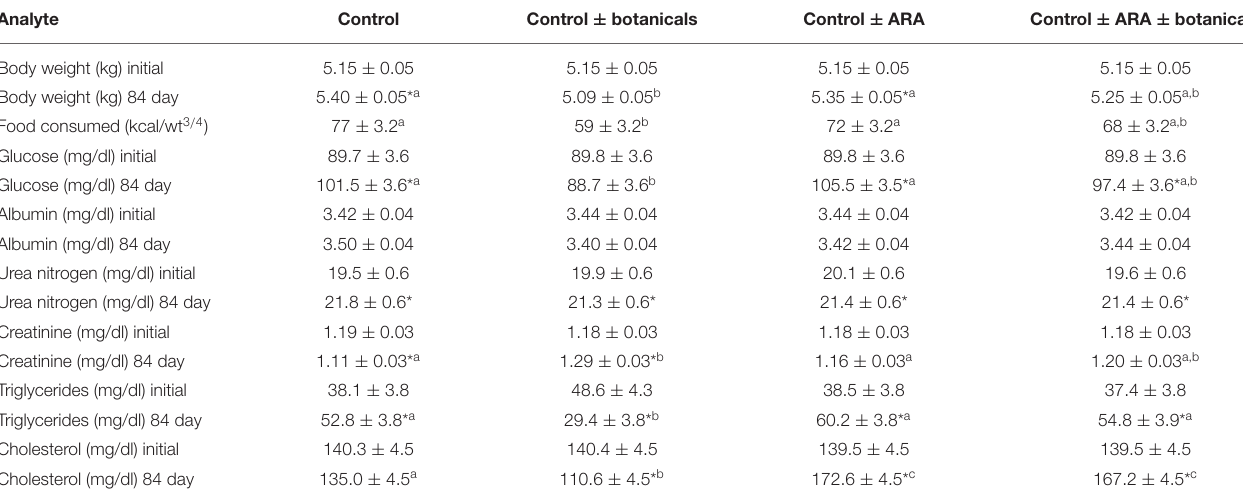
TABLE 2 | Body weight and selected serum biochemistries from serum biochemical profiles (values are lsmeans + standard errors).